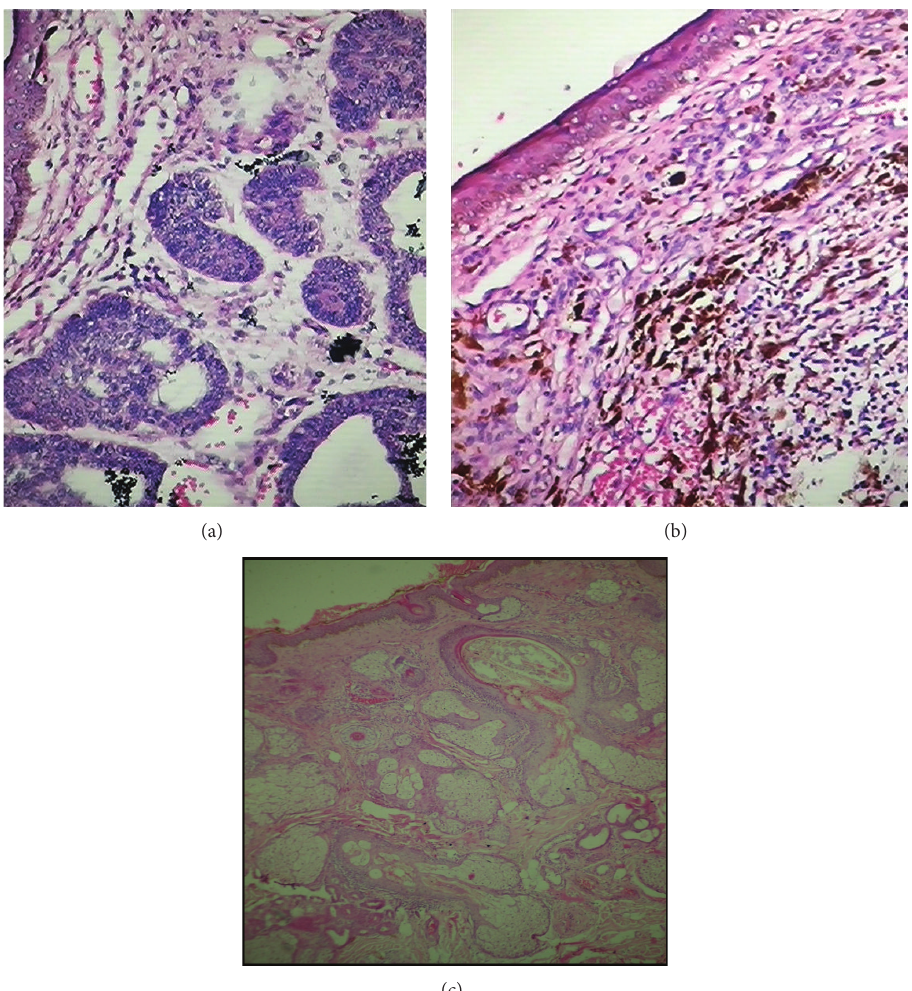
Figure 3: (a) Histopathology (hematoxylin and eosin, 40x): nodular BCC. (b) Histopathology (hematoxylin and eosin, 40x): pigmented BCC. (c) Histopathology (hematoxylin and eosin, 10x): adenoid BCC.